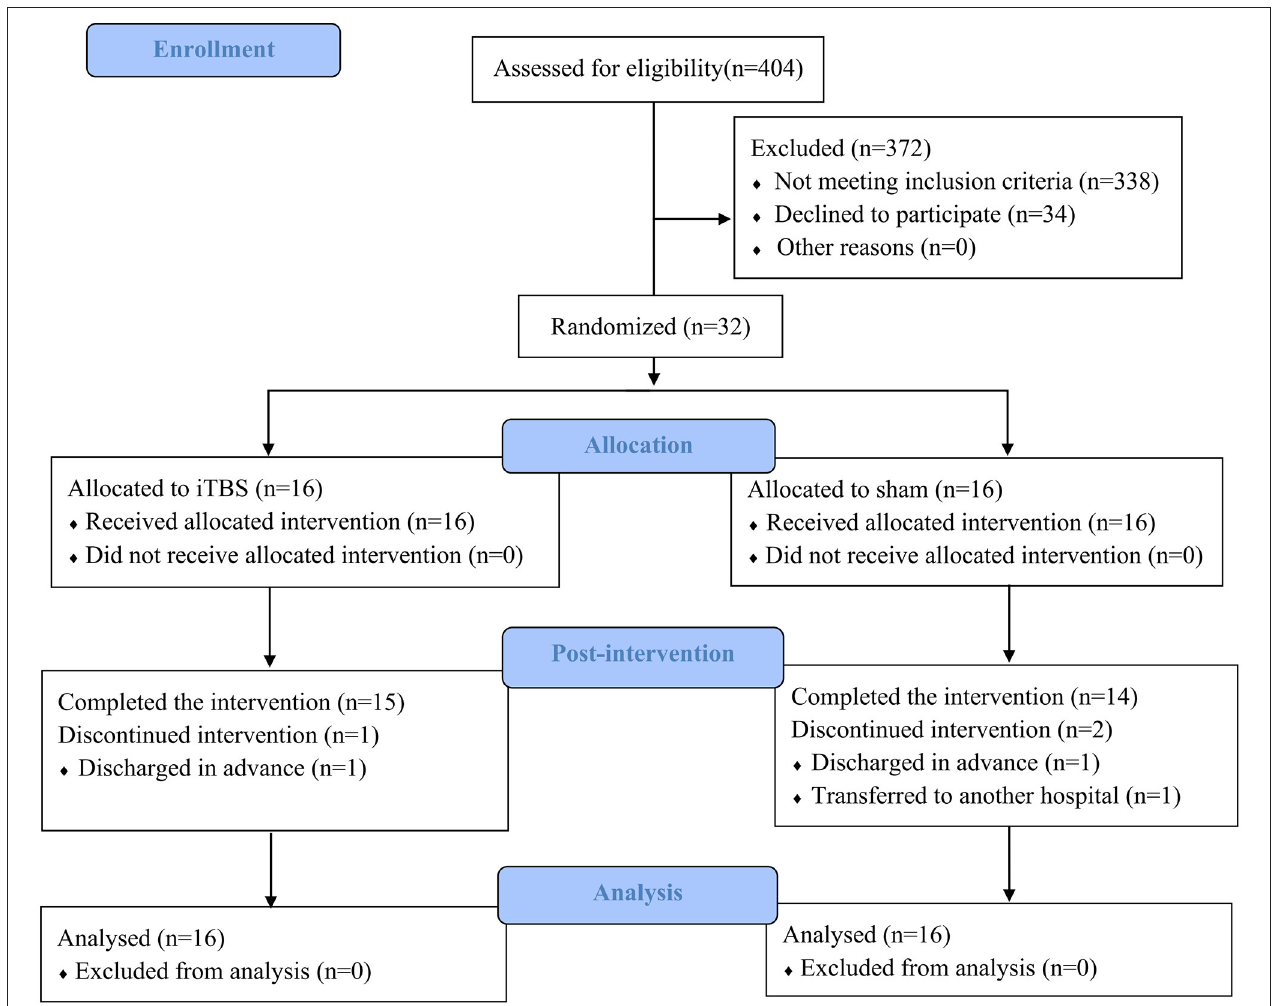
FIGURE 1 | Consolidated standards of reporting trials flow diagram of the trial. iTBS, intermittent theta-burst stimulation.